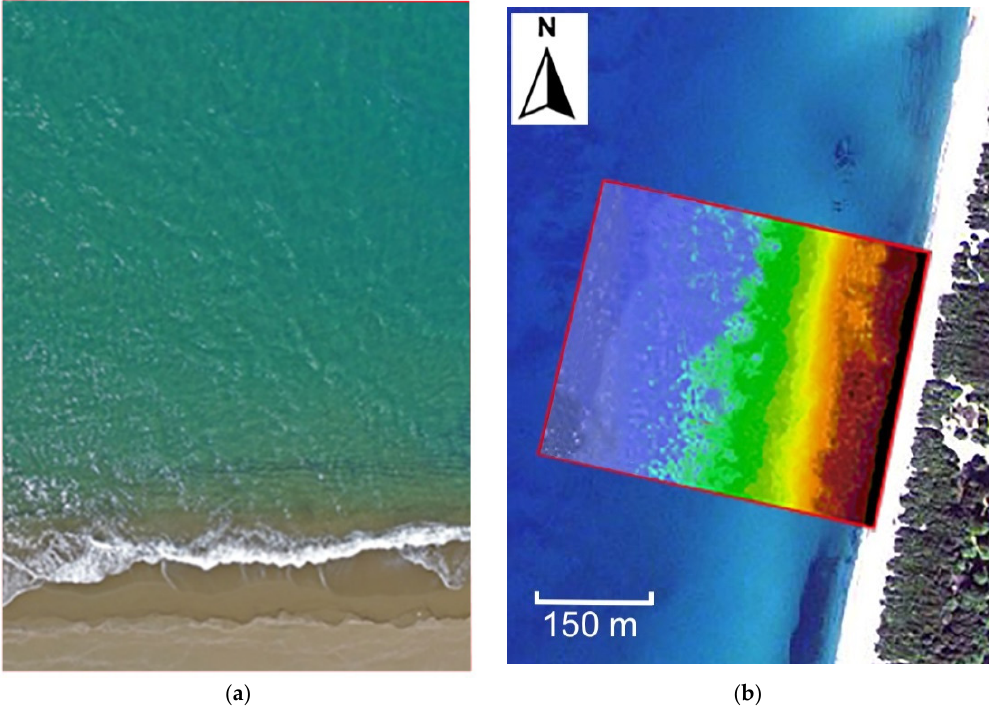
Figure 7. Example of one of twelve UAV RGB images of 96 × 72 m ( a ) and a UDB relative water depth map in the study area acquired using the Stumpf method ( b ).